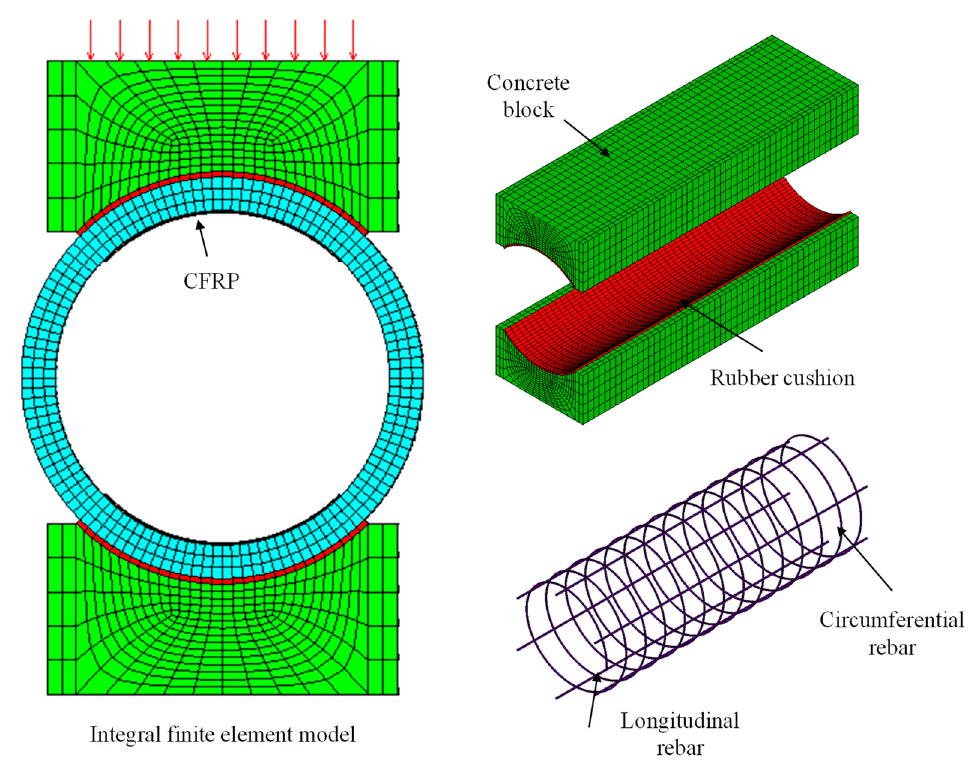
Figure 7. Numerical model.